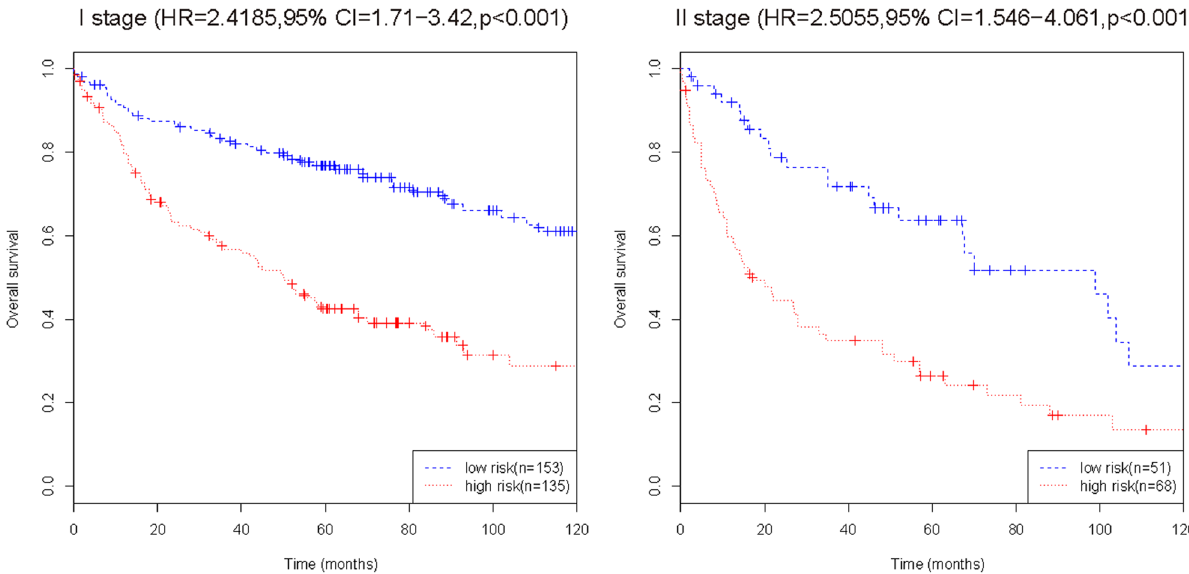
Figure 7. Kaplan–Meier curve analysis of RFS according to the fifteen-mRNA signature for stage I/II patients in the combined training set and internal validation set. The Kaplan–Meier curve further showed that the RFS of the high-risk group was significantly shorter than that of the low-risk group ( P <